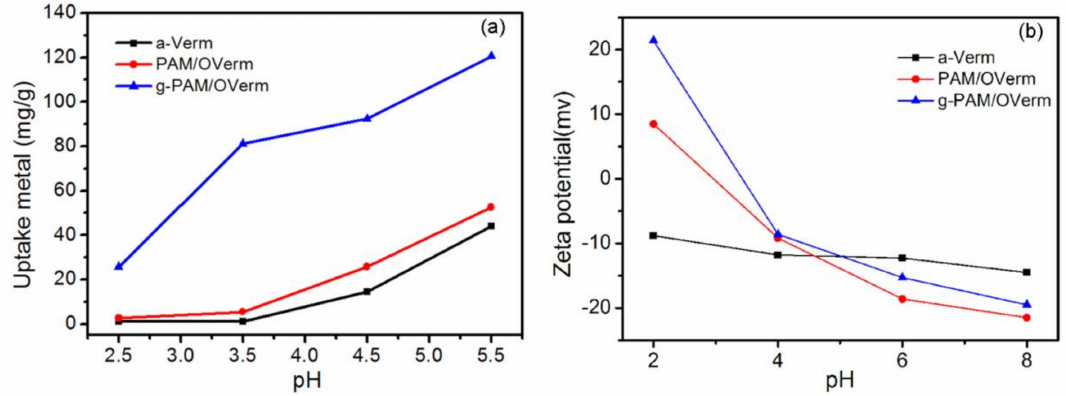
Figure 10. ( a ) Effect of pH on adsorption of Pb(II) (Reaction conditions: C i = 400 mg · L − 1 , contact time t = 120 min, 0.05 g adsorbent); and ( b ) effect of solution pH on the zeta potential of a-Verm, PAM/OVerm and